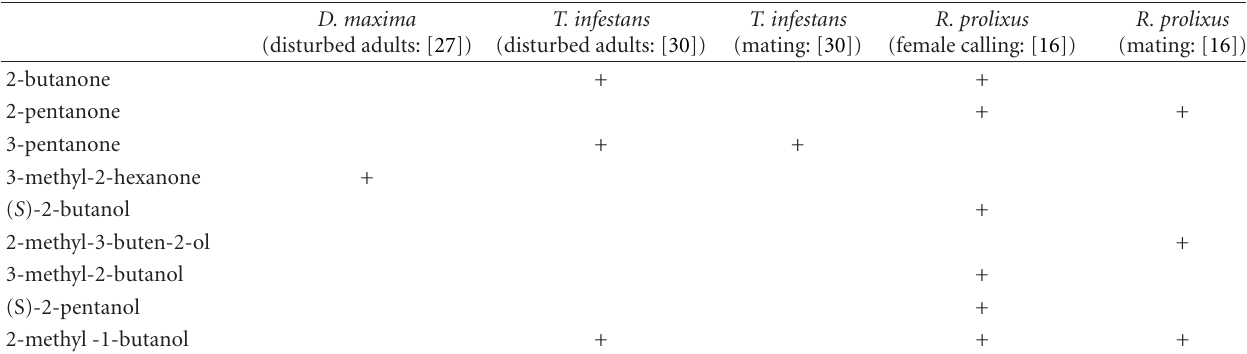
Table 2: Compounds associated with metasternal gland secretions of di ff erent triatomine species emitted in di ff erent behavioural contexts (references cited in